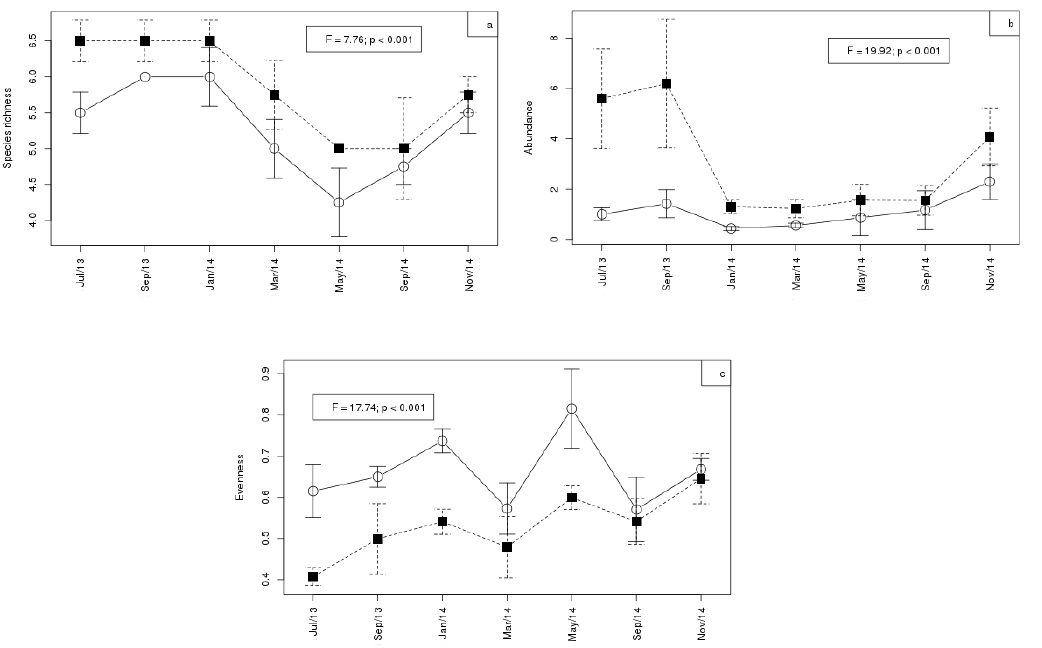
Figure 4. Average richness ( a ), abundance ( b ) and evenness ( c ) of microcrustacean assemblage (vertical bars: standard error) per month sampled ( ○ = central compartment, ■ = lateral compartment) of the reservoir Barragem da Pedra, Jequié, Bahia.